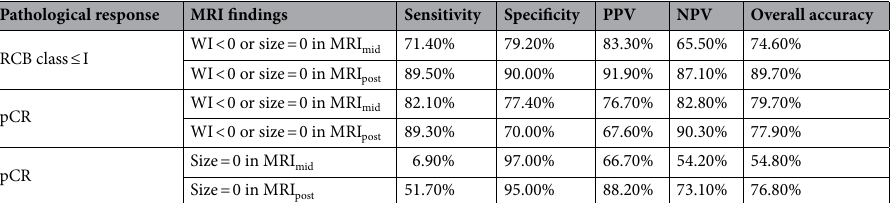
Table 2. Diagnostic performance of DCE-MRI findings in predicting pathological responses. DCE-MRI: dynamic contrast-enhanced magnetic resonance imaging, PPV: positive predictive value, NPV: negative predictive value.